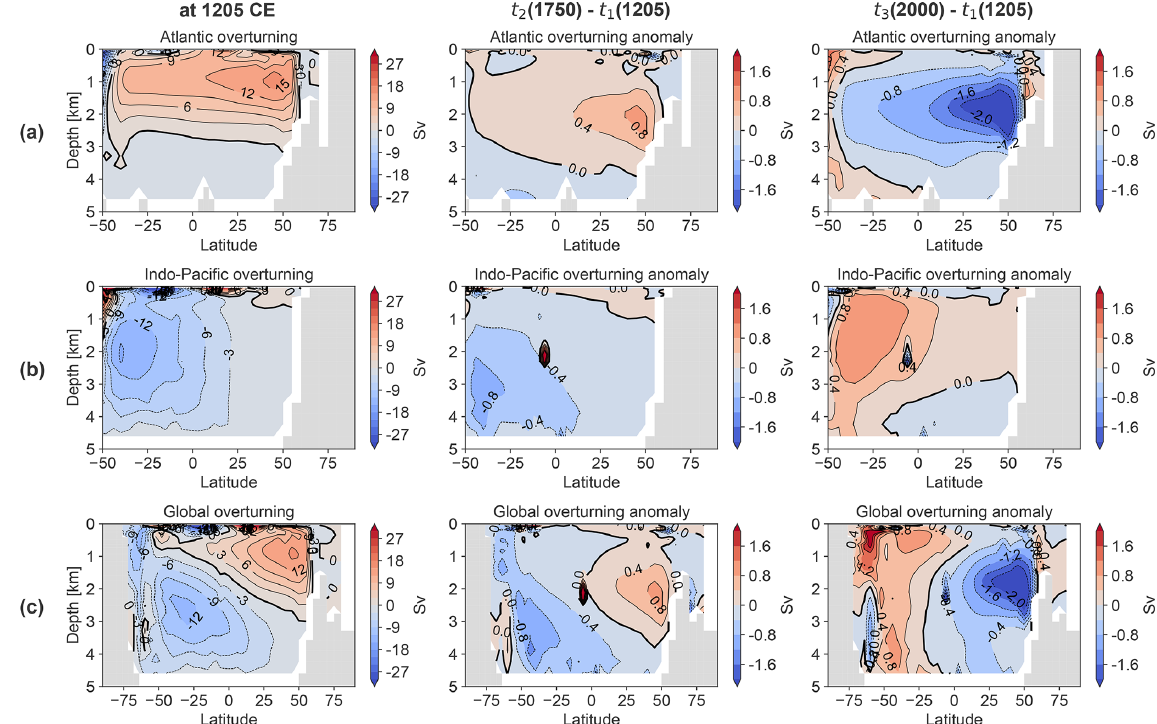
Figure 3. Meridional overturning circulation for the transient ocean-only simulation OcTRA for (a) the Atlantic (AMOC), (b) the Indo- Pacific (IPMOC) and (c) globally at different time steps: at the start (1205CE) and the anomalies at the coldest point of the Little Ice Age (1750CE) and in 2000CE. Values are averages over 15 years (for 1205–1220CE) and 30 years (around 1750 and 2000CE). Note the changing colour bar and latitude axis. The overturning stream function is positive (red) for water rotating clockwise and negative (blue) for water rotating